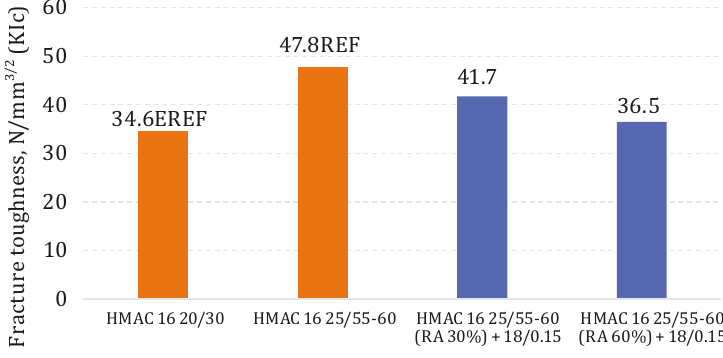
Figure 7. SCB performance results for the base layers